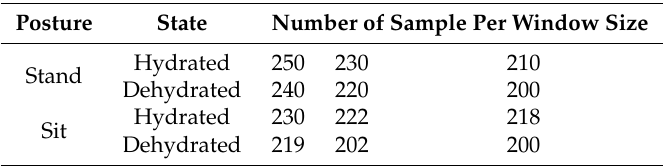
Table 1. Data samples of